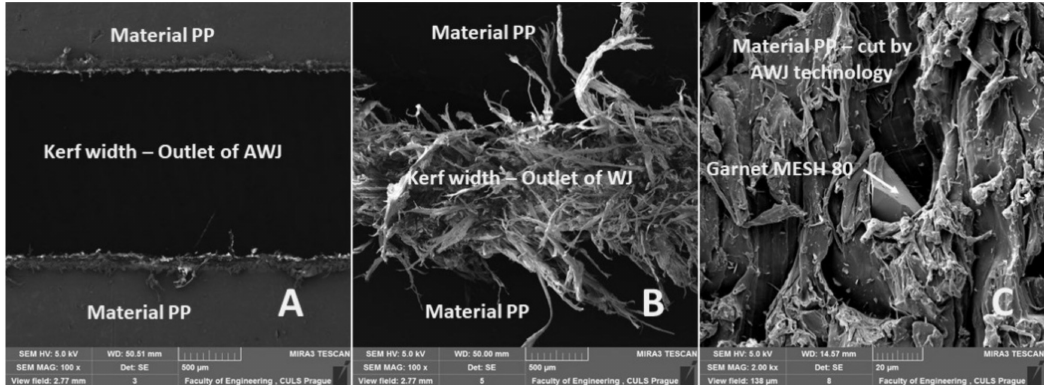
Figure 19. View of the cut of the tested material PP + MOBIHEL at a cutting head traverse speed of 50 mm · min − 1 : ( A ) cutting groove created by AWJ technology—outlet side of the abrasive waterjet without significant deformation of the cutting edges (MAG 100 × ); ( B ) cutting groove created by WJ technology—outlet side of the waterjet with significant deformation of the cutting edges (MAG 100 × ); ( C ) cutting area created by AWJ technology with a noticeable abrasive particle from the cutting process (MAG 2000 ×